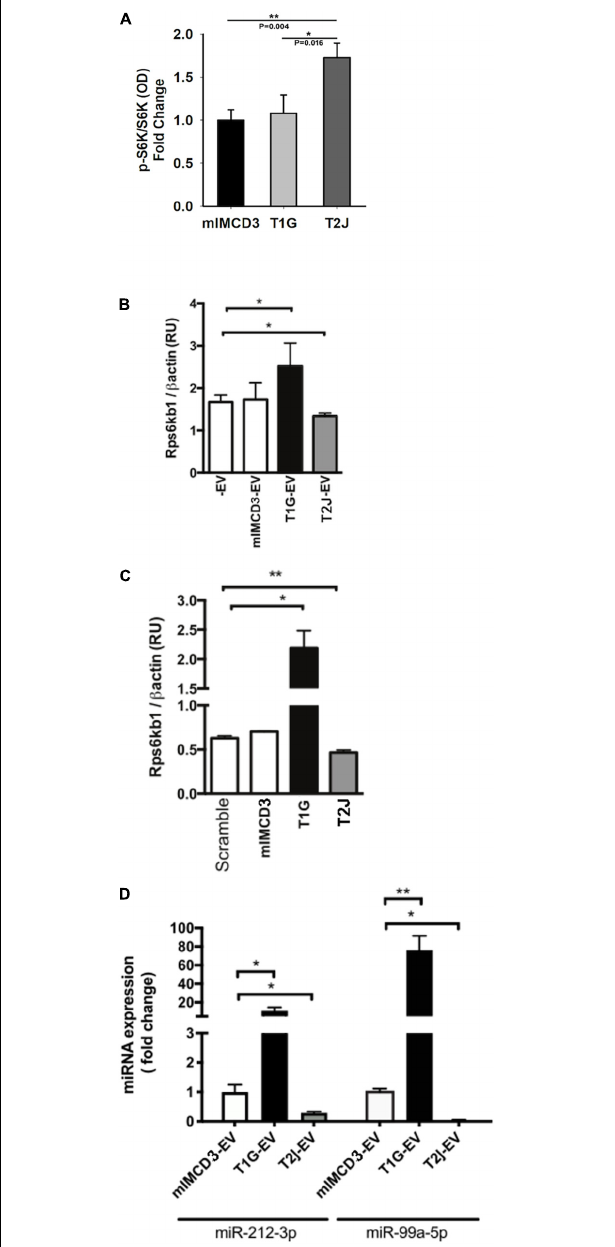
FIGURE 4 | Cellular effects of EVs from Tsc1 - or Tsc2 -deleted cells on recipient cells. (A) Effect of EV treatment on mTORC1 signaling on the pS6K/S6K ratio. All values normalized to mIMCD3 and reported as fold change. (B) Effect of EV treatment on S6K mRNA ( Rps6kb1 ) expression normalized to the expression of β -Actin. -EV means no EVs, and the cell type that produced the EVs is indicated. (C) Effect of total RNA (isolated from EVs) transfection on S6K mRNA expression. RNA extracted from mIMCD3, T1G, and T2J-EVs was transfected into serum-starved M1 cells. For the control, scrambled RNA was used ( n = 3). S6K ( Rps6kb1 ) gene expression was normalized to β -actin expression (RU: relative expression unit). (D) miRNA expression in mIMCD3, T1G, and T2J cells. Gene expression was normalized to the global mean of three loading controls. All experiments were performed in triplicate ( n = 3), and statistical analysis was performed using one-way ANOVA followed by Tukey’s test (* p < 0.05, ** p <